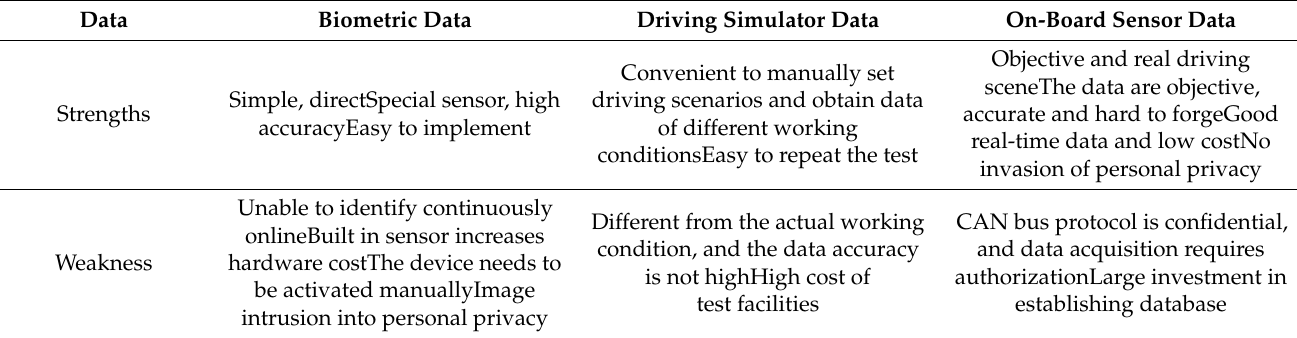
Table 1. Strengths and weakness of different data.